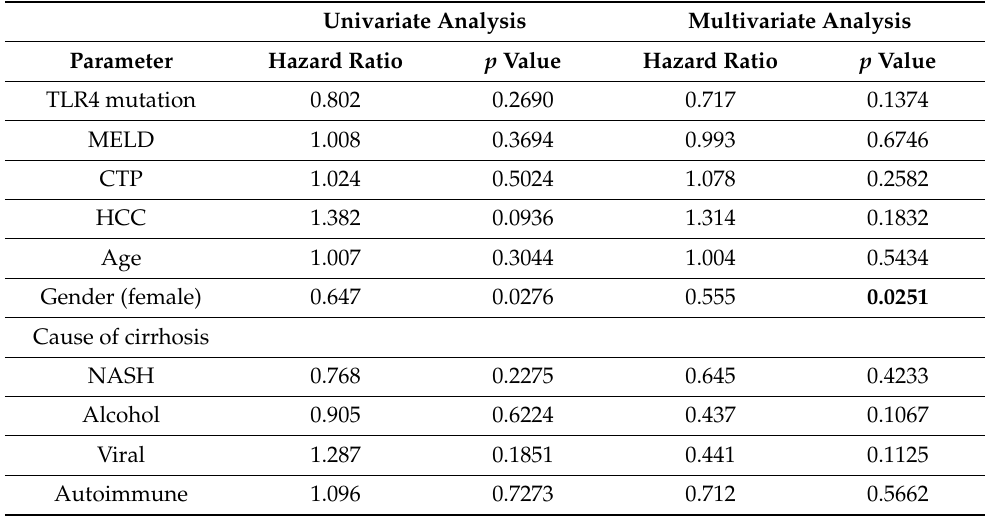
Figure 2. Survival curves for liver-related deaths for the patients with HCC in relation to TLR4 mutations. Shaded area indicates the 95% confidence interval. Table 3. Uni- and multivariable analyses for the time from cirrhosis until death. p values in bold indicate statistical